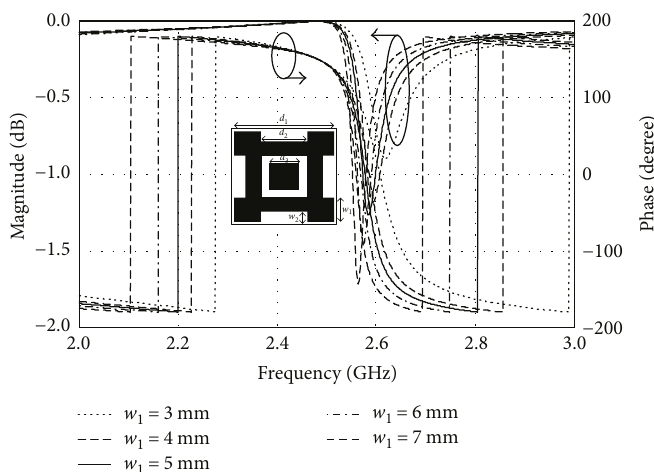
Figure 4: The simulated magnitude and phase of the re fl ection coe ffi cient of the modi fi ed FSS cell for various w